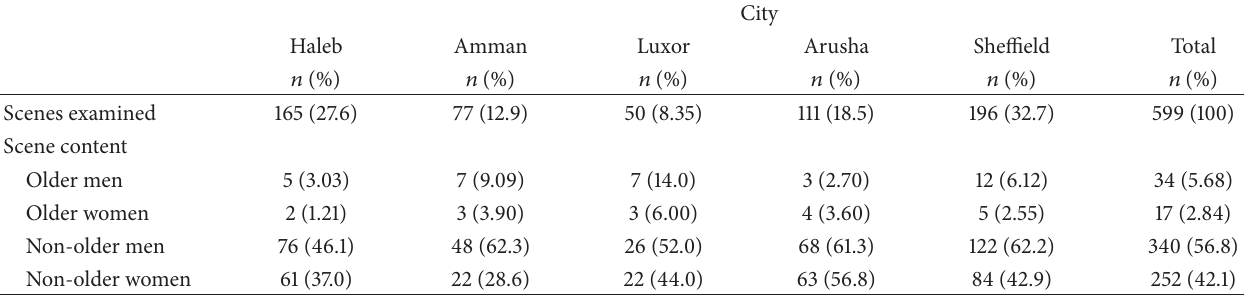
Table 4: Images of people by age and gender in scenes on television from five